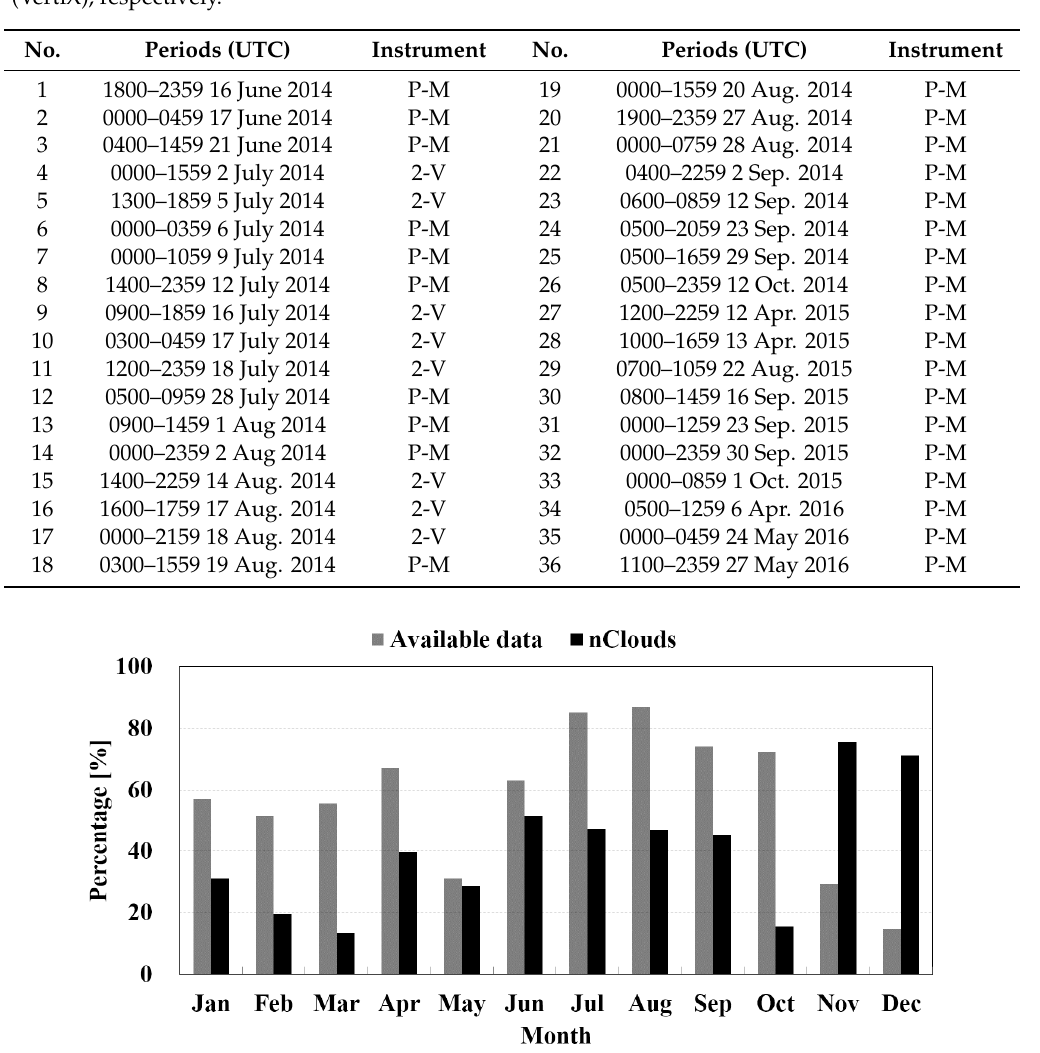
Figure 2. The monthly percentages of available reflectivity data (light bar) and cloud occurrences (dark bar) averaged from June 2014 to May 2016.